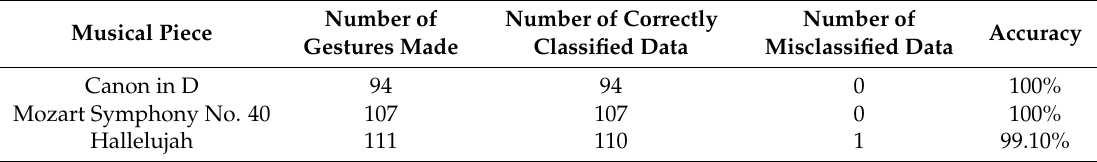
Table 7. Accuracy of musical conducting gesture recognition in a whole musical piece. Musical Piece